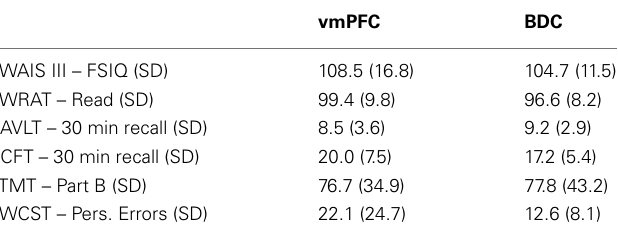
Table 2 | Neuropsychological data for the lesion